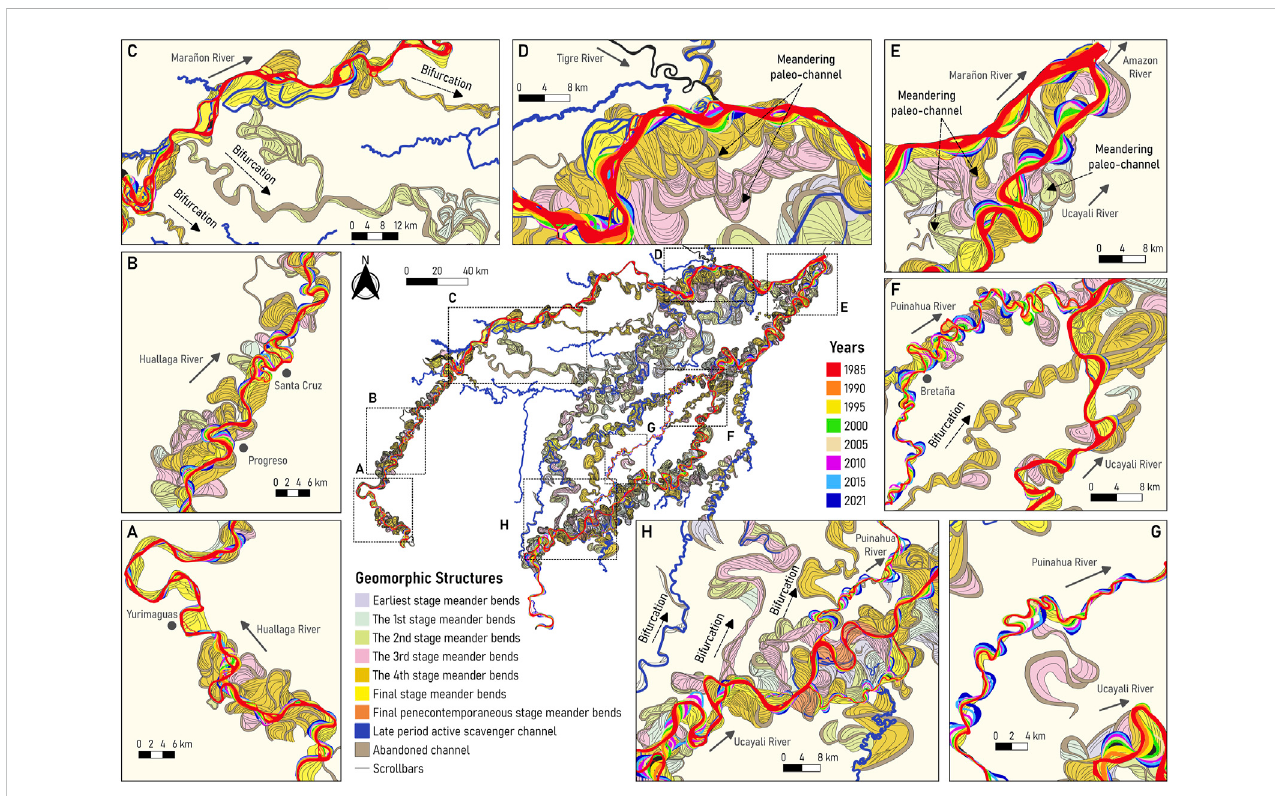
FIGURE 4 Ancient and modern river dynamics of the buffer zone in the P-S wetland. (A) Huallaga River near Yurimaguas city, (B) Huallaga River near Progreso and Santa Cruz cutoffs, (C) Birfurcated channels along the Marañon River, (D) Con fl uence of the Tigre and Marañon Rivers, (E) Con fl uence of the Marañon